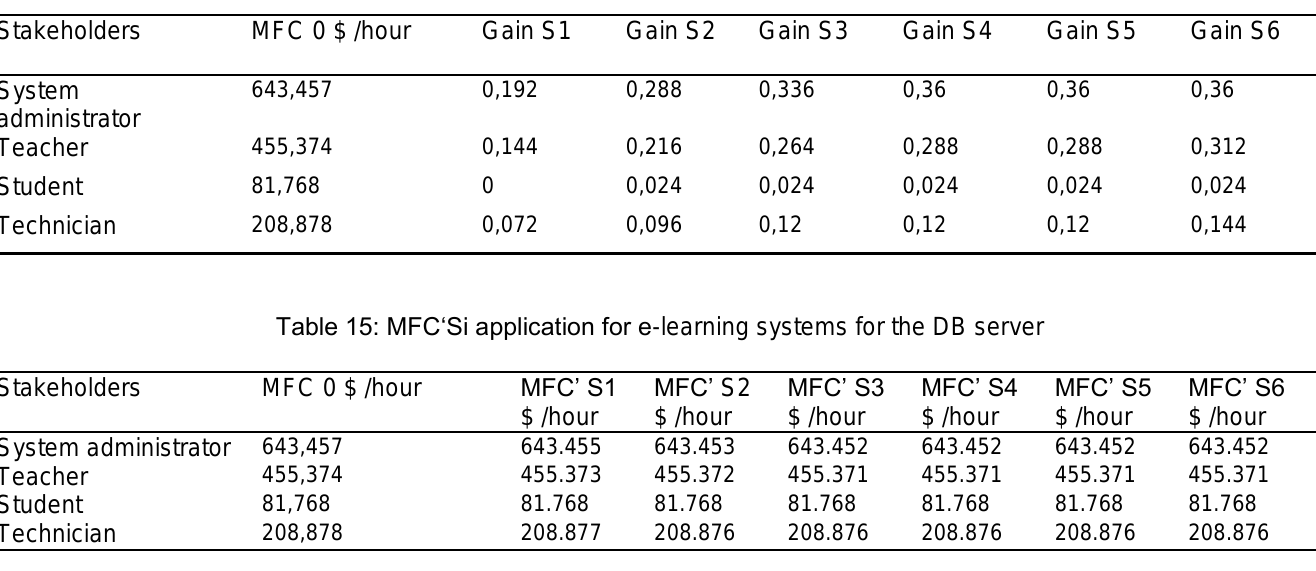
Table 13: Gain for the web server